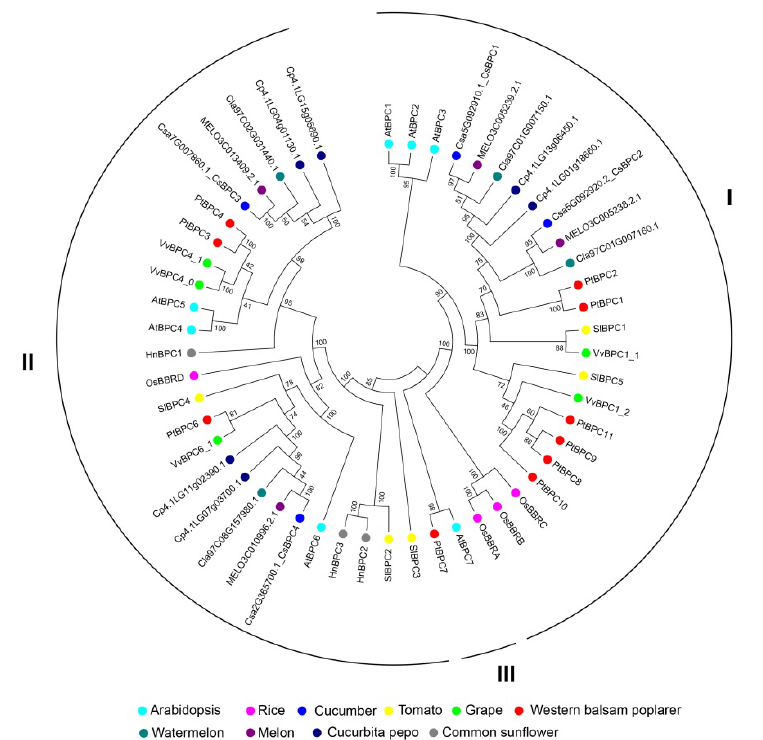
Figure 2. Phylogenetic analysis of BPC proteins from cucumber and other species. BPC polypeptide sequences generated from four cucumber, seven Arabidopsis , four rice, four watermelon, four melon, six cucurbita pepo, five grape, ten western balsam poplar, three common sunflower, and five tomato (SlBPCs) plants were used to construct an unrooted neighbor-joining phylogenetic tree by MEGA7 software with 100 bootstrap replicates. The different colored dots indicate different species.